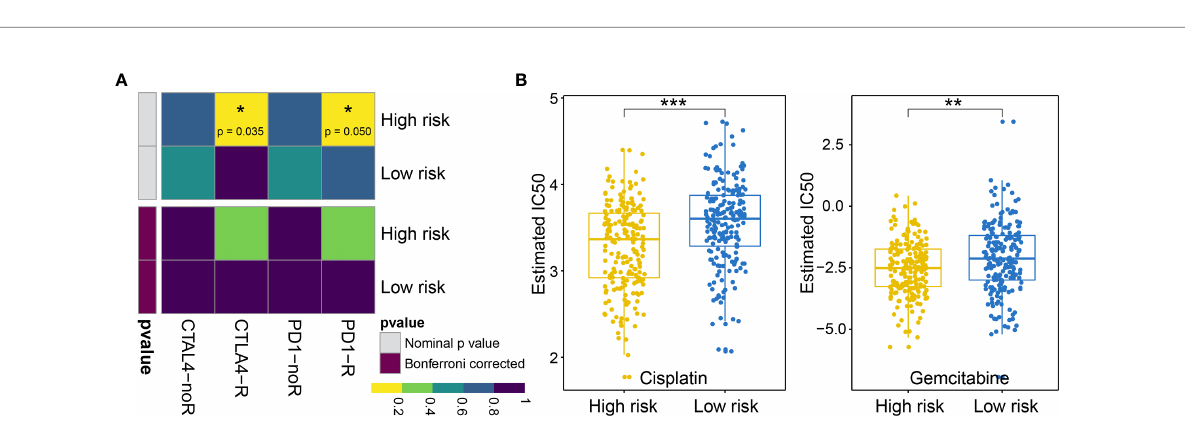
FIGURE 9 | (A) Difference in the immunotherapy responses among BLCA patients at high and low risk of OS. (B) Differences in the cisplatin and gemcitabine chemotherapy responses among patients with BLCA at high and low risk of OS. * represents p values< 0.05, ** represents p values < 0.01, *** represents p values<